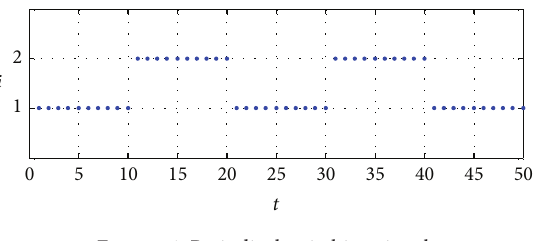
Figure 4: Periodical switching signal.